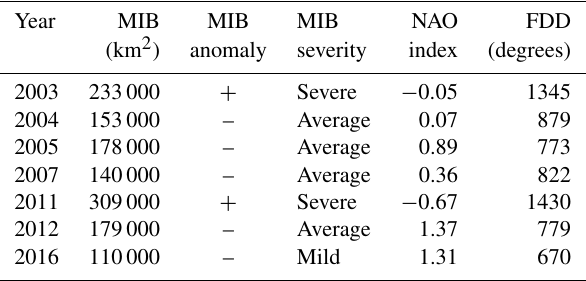
Figure 3. Average number of days with ice chart ridging index 3 (ridged ice) or 4 (heavily ridged ice). Table 2. Maximum annual Baltic Sea ice extent (MIB) in the years of EM ice thickness surveys. MIB anomalies are based on years 1961–2010. Also listed are ice severity according to Finnish Ice Service, North Atlantic Oscillation (NAO) index, and the amount of freezing degree days in